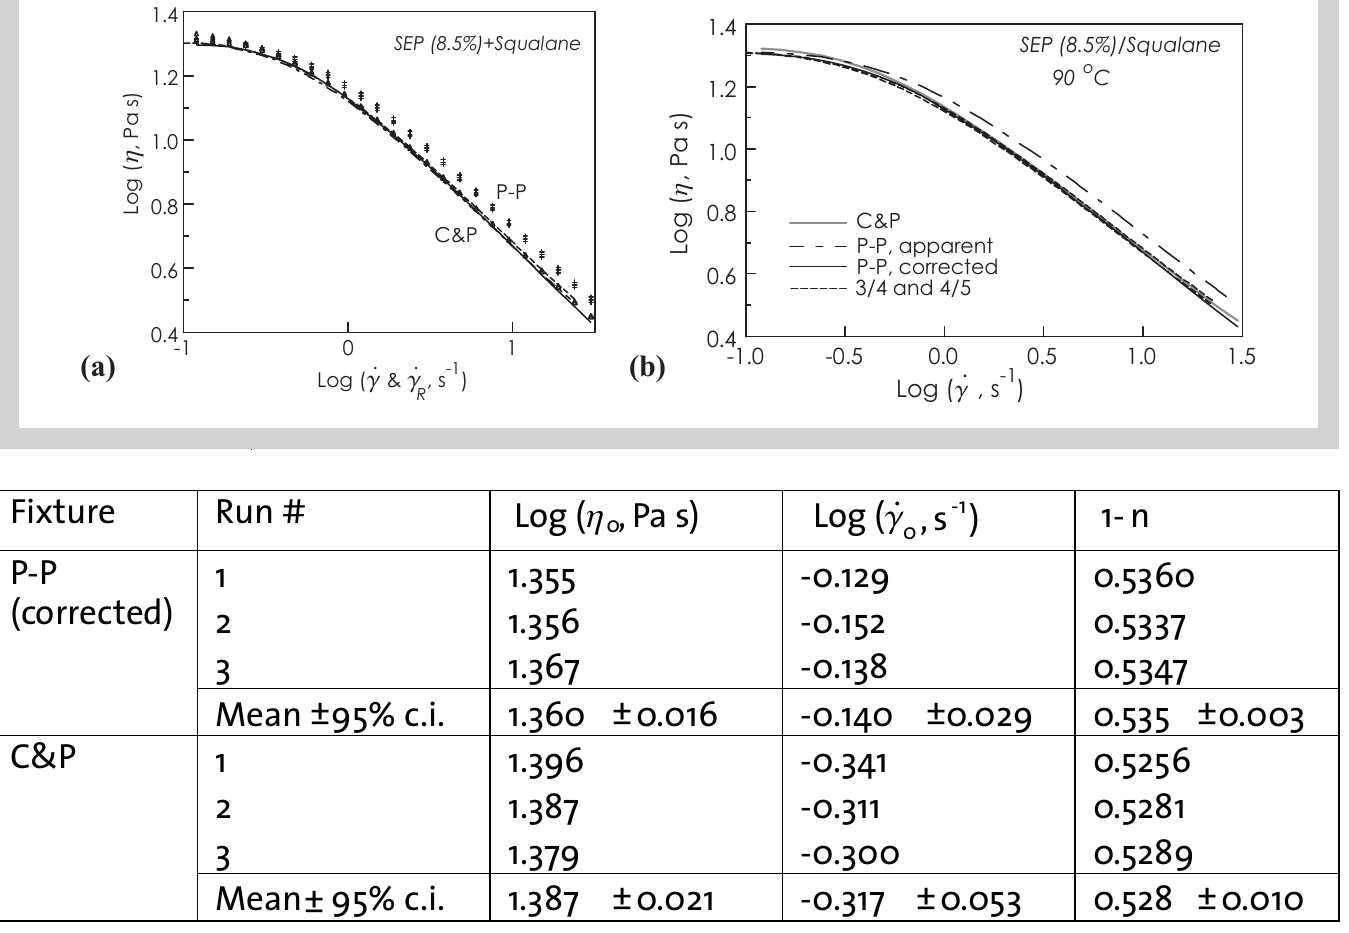
a Runs are independent, in that the fixtures were cleaned and reloaded between each run. Figure 5 (above): a) Steady shear viscosity of 8.5 wt% SEP in squalane at 90º C. Data for each fixture include three independent runs + P-P and D C&P. The center P-P run has been con- ventionally corrected to give the dotted lines near the C&P data. b) Combined data from three runs each of C&P and P-P. The 3/4 ths and 4/5 ths corrections are shown as thin dotted lines. Table 1: Steady shear a of 8.5% SEP solution in squalane at 90˚C (Carreau-type (Eq. 16) para- meters). Figure 6: Comparison of transient shear results for C&P and P-P fixtures for 7.5% SEP/squalane solution at 30º C (Curves are averages of four runs for each condi-